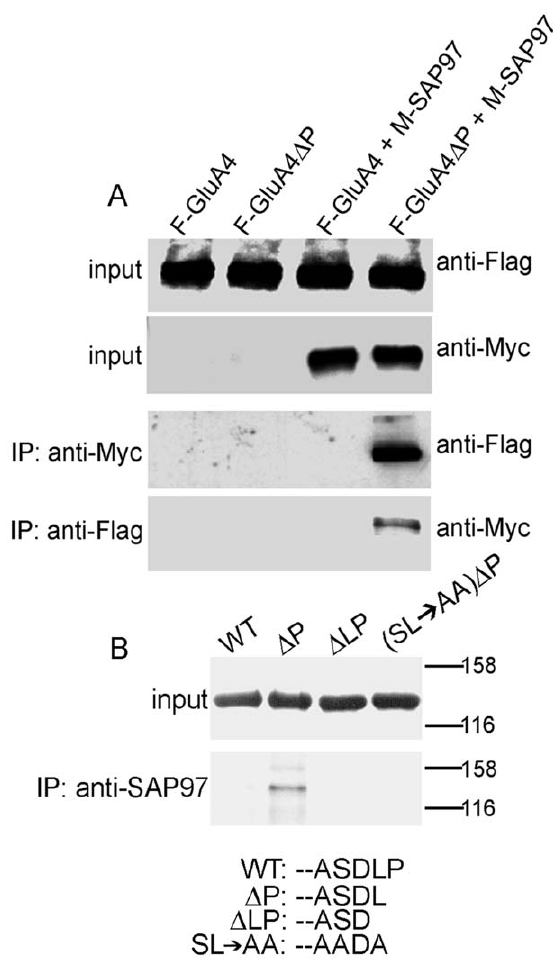
Figure 2. Deletion of proline-902 exposes a functional PDZ motif in GluA4 and confers binding to SAP97. (A) Expression of wild-type or mutant GluA4, with or without co-expressed myc-tagged SAP97 in HEK293 cells. Upper panels show expression of all proteins; lower panels show co-immunoprecipitation of GluA4 D P, but not full- length GluA4 with SAP97. Immunoblotting antibodies are indicated on right. (B) Transiently expressed GluA4 D P can co- immunoprecipitate with endogenous SAP97 from HEK293 cells. Upper panel shows similar expression levels of transfected GFP-tagged constructs. Lower panel show immunoprecipitation with anti-SAP97 specific antibody. Both blots were probed with anti-GFP IgG. The extreme carboxyterminal sequences of the expressed proteins are shown below.